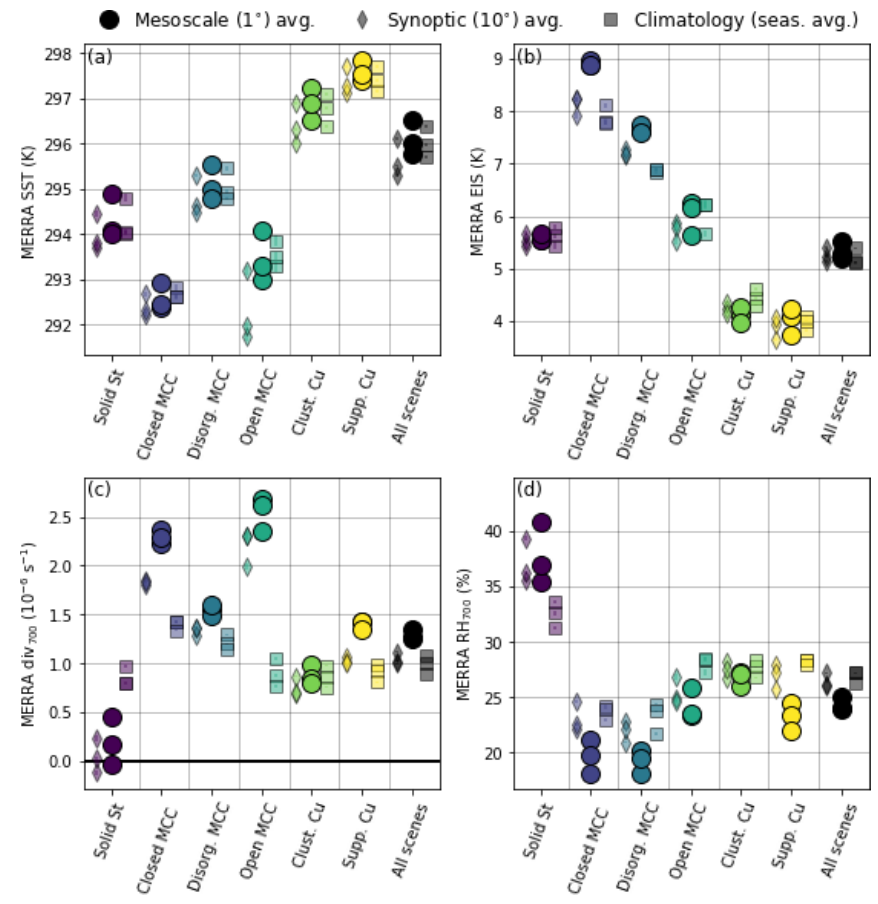
Figure 5. Same as Fig. 4a but for (a) MERRA-2 sea surface temperature, (b) MERRA-2 estimated inversion strength (EIS), (c) MERRA-2 700hPa divergence, and (d) MERRA-2 700hPa relative